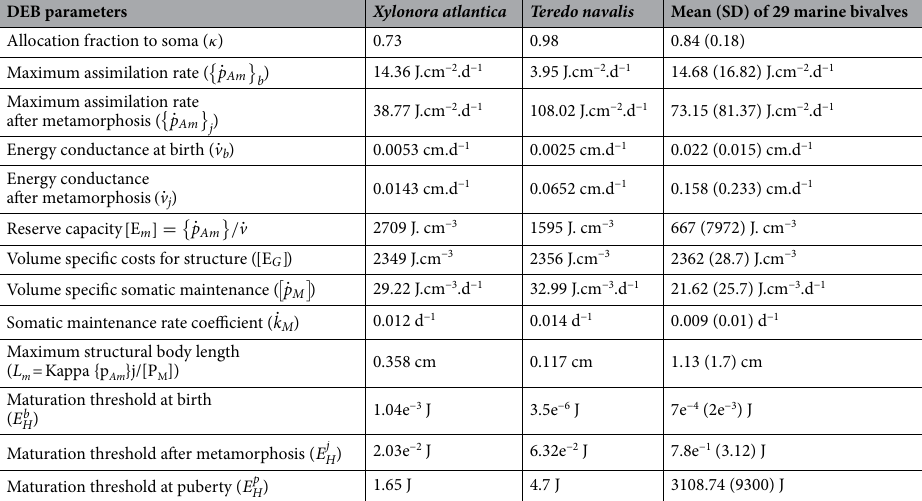
(Fig. 3). The results of the abj-DEB model matched the observations obtained in situ (Supplementary Fig. S2 online), suggesting that food level f was close to 1 in the colonization experiment after 410 days. The von Bertalanffy growth rate was twofold higher at T = 11 °C than at T = 4 °C for the same f . X. atlantica took 316 days to reach puberty under the environmental conditions at 2300 m in depth at satiety compared with only 155 days under the environmental conditions at 100 m in depth (Table 3). For f = 0.5, age at puberty was only reached after 494 days under deep-sea conditions (Table 3). The total reproductive output (TRO) is generally low both at 4 °C (deep-sea conditions) and at 11 °C (100 m conditions) at satiety (Table 3). If food density is reduced by half at the deep-sea temperature, then the TRO is even smaller (1228 oocytes) (Table 3). The parameters of the abj-DEB model allowed us to estimate the time spent in the water column (pelagic larval duration: PLD) between hatching (trochophore) and settling (postlarval stage), giving a range of PLD from a minimum of 17 days ( f = 1 at 16 °C; surface dispersal) to a maximum of 127 days ( f = 0.5 at 4 °C; demersal dispersal) (Table 4). With demersal dispersal, PLD varied between ~ 3 months ( f = 1) and ~ 4.5 months ( f = 0.5). At depths of 100 m, PLD ranged from ~ 1 month ( f = 1) to ~ 2 months ( f = 0.5). With surface dispersal, PLD varied between 17 and 29 days. Xylonora atlantica dwarf males in the deep sea: how is it possible? Different scenarios were inves- tigated to explain how some individuals (males) of X. atlantica reach sexual maturity with very slow or null growth of their shell. Either a decrease in the scaled functional response f or a change in the allocation fraction to soma ( κ) were tested. The mean shell height of the dwarf males recovered from CHEMECOLI after 410 days of deployment was 547.6 µm (SD = 31.5 µm; n = 64). First, at a temperature of 4 °C using the abj-DEB model, only a f value of 0.05 after the completion of metamorphosis gave a maximum shell height of ~ 0.055 cm after 410 days